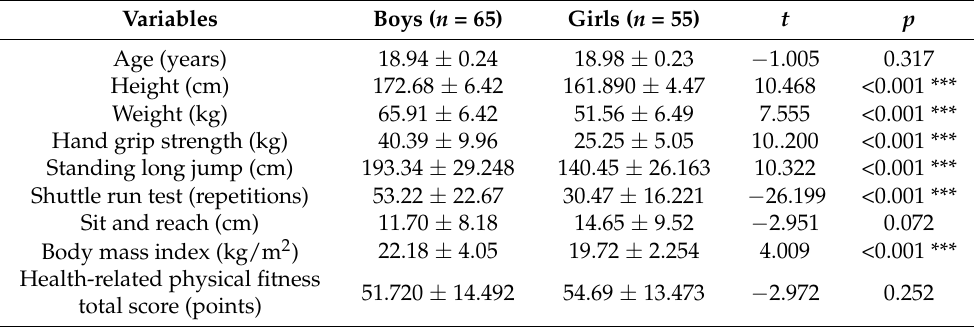
Table 1. Participant characteristics by sex.